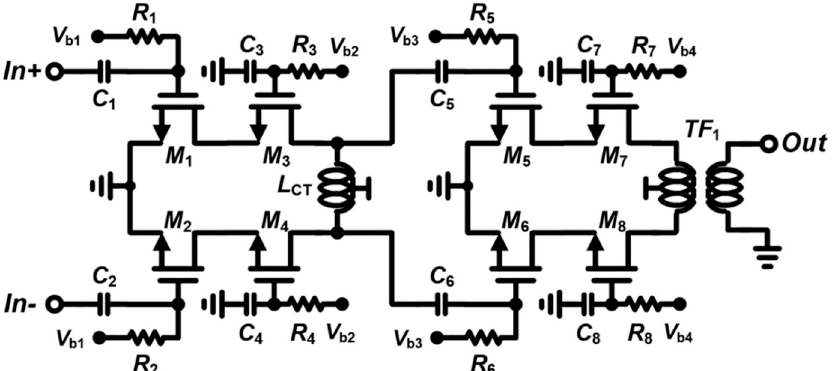
Figure 9. Simplified schematic of the two-stage power amplifier.